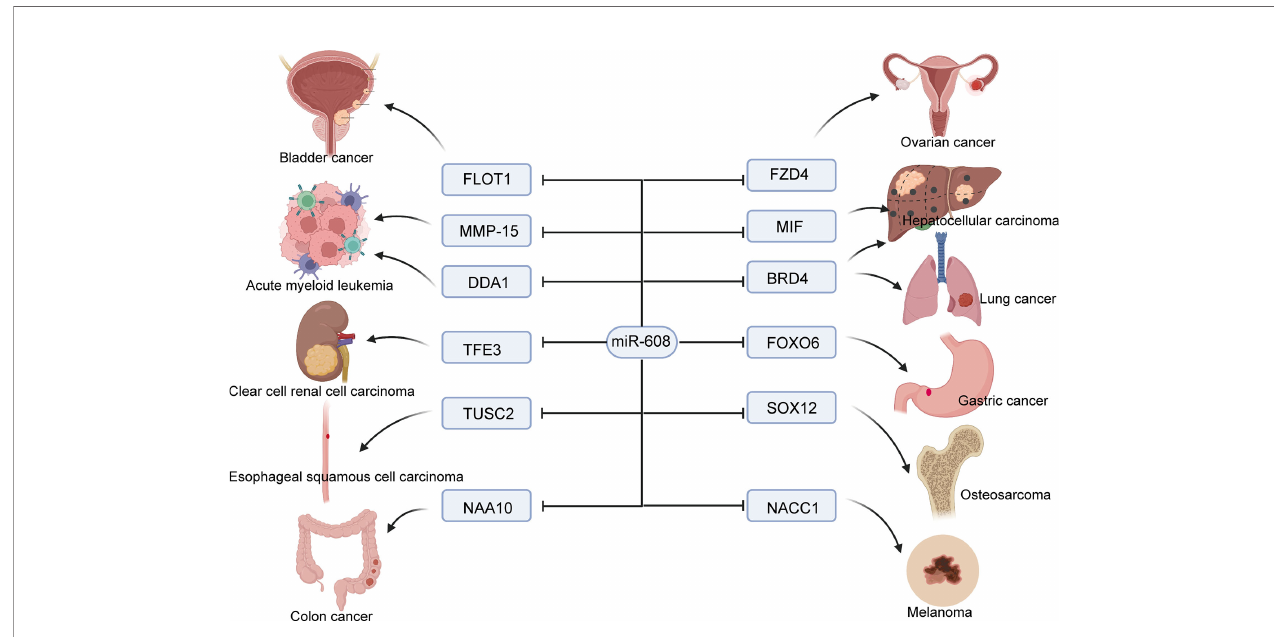
FIGURE 2 | Molecular mechanism of miR-608 affecting tumor cell proliferation. miR-608 targets a large number of genes to inhibit cancer cell growth, including bladder cancer, ovarian cancer, lung cancer, liver cancer, and renal cancer,